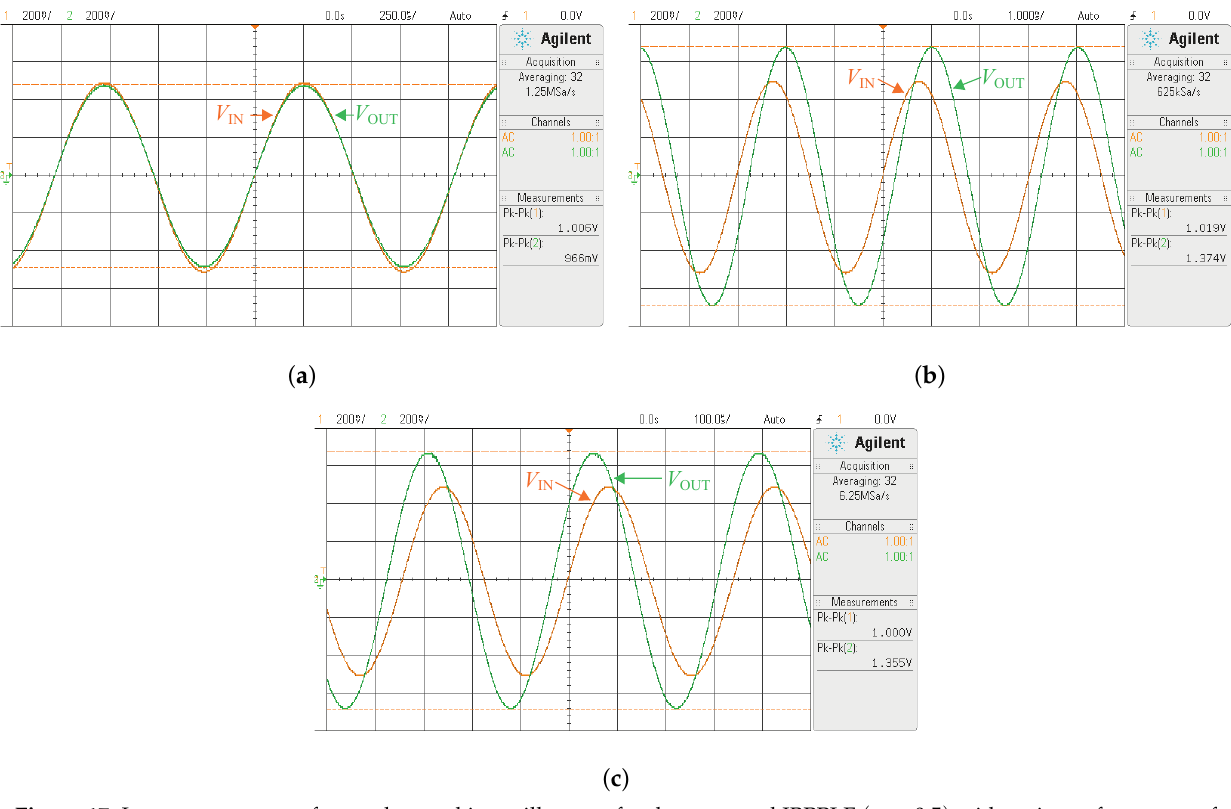
Figure 17. Input–output waveforms observed in oscilloscope for the proposed IBPPLF ( α = 0.5 ) with an input frequency of